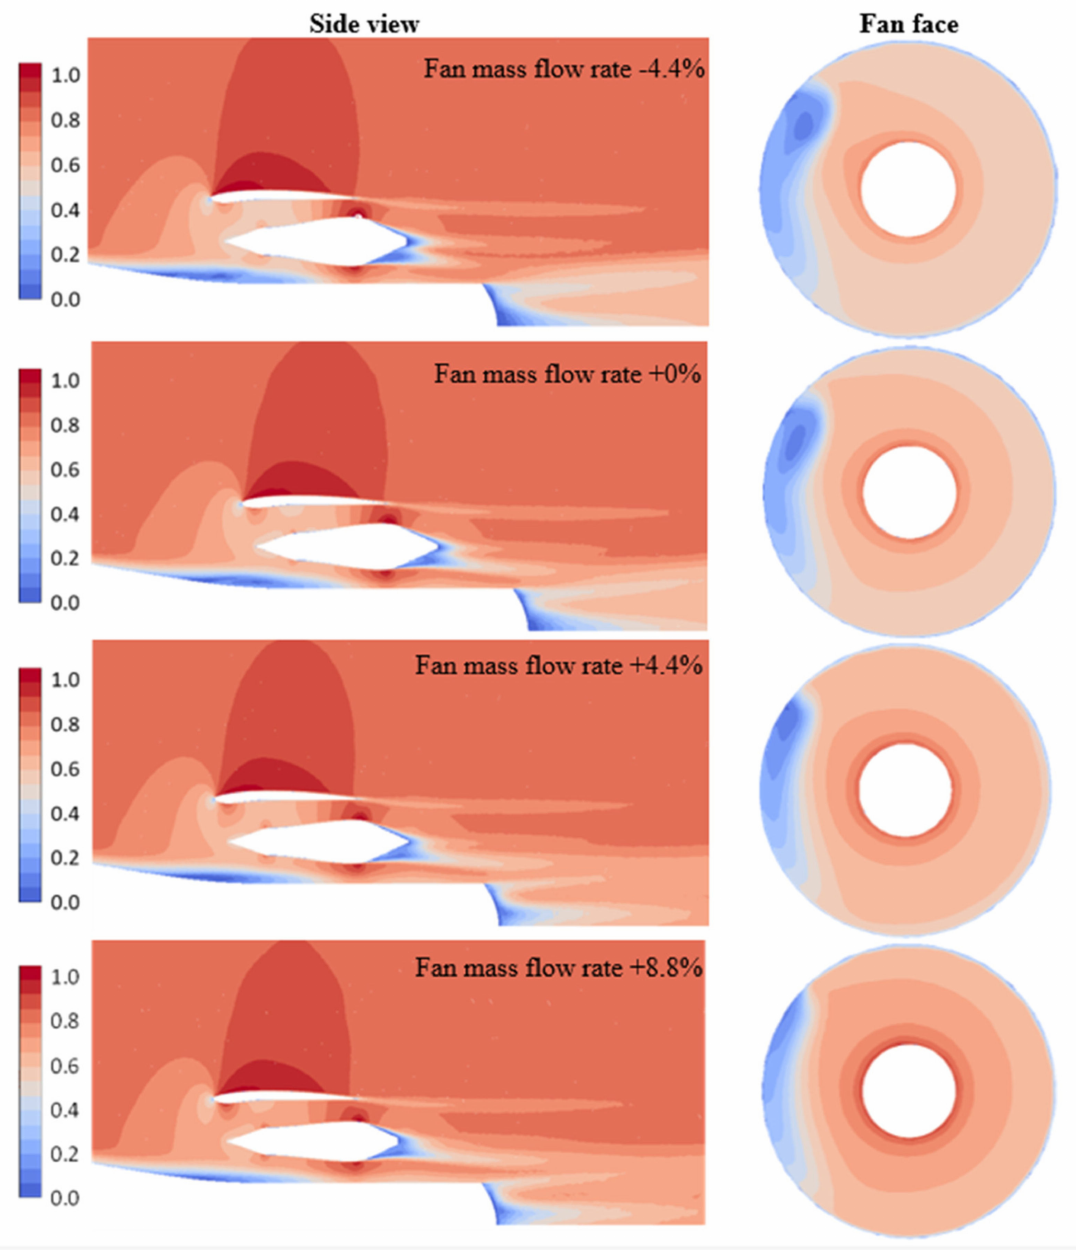
Figure 17. Contours of Mach number in the planes of interest ( from left to right : mid-plane cross- section and fan inlet), results from the 3D simulation of mass flow variation cases ( from top to bottom : − 4.4% fan mass flow, baseline, +4.4% fan mass flow and +8.8% fan mass